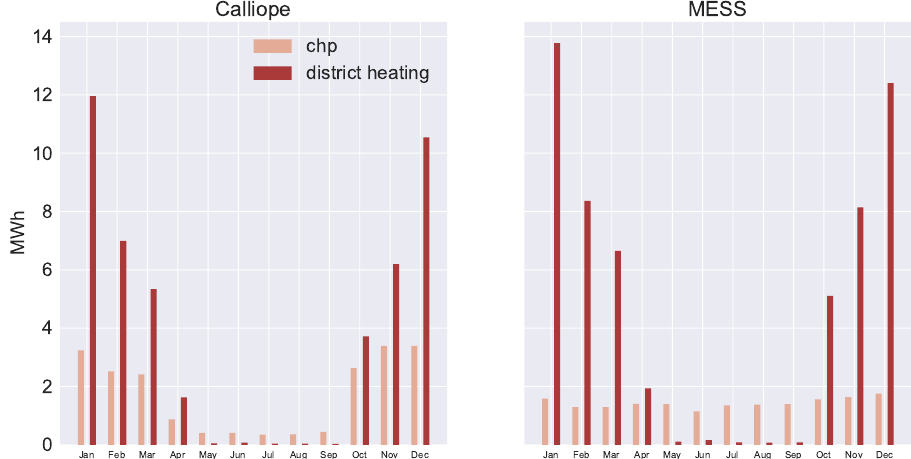
Figure 8. Monthly heating per source: Location X1—Calliope and MESS